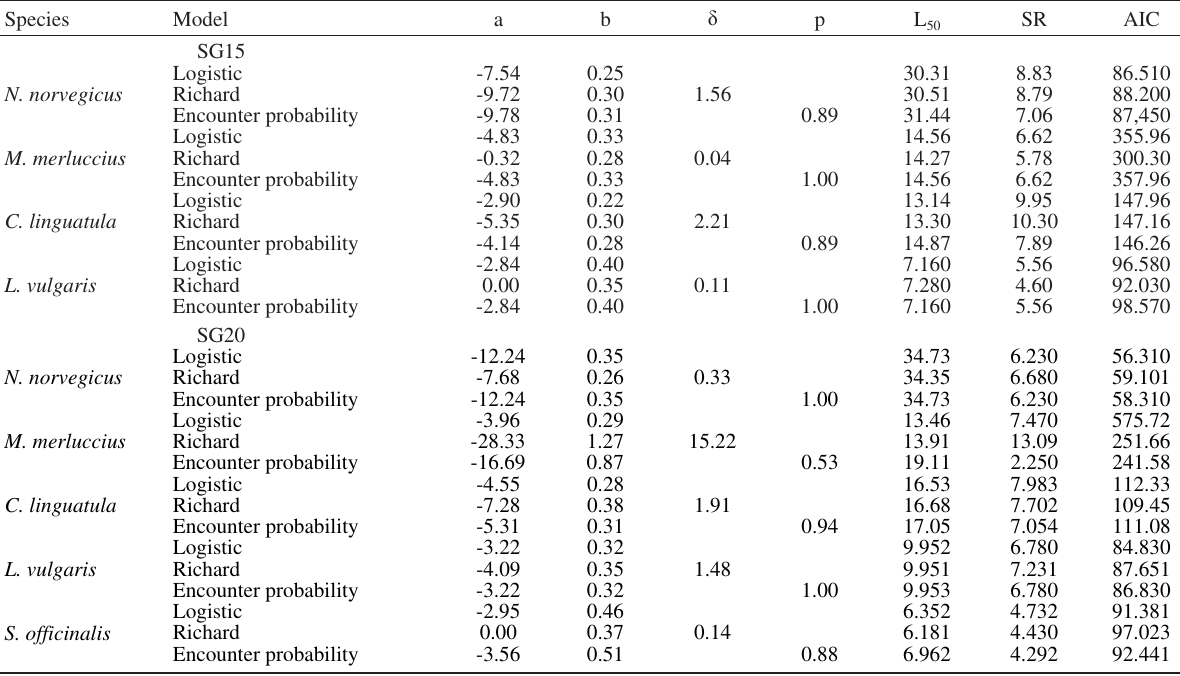
Table 5. – Escape selection curve parameters (a, b, δ and p), length of 50% escapement (L ) in cm for fish species and cuttlefish and mm for 50 N. novergicus , and selection range (SR) for the main commercial species for sorting grids with 15 and 20 mm bar spacing (SG15 and SG20, respectively). AIC, Akaike information